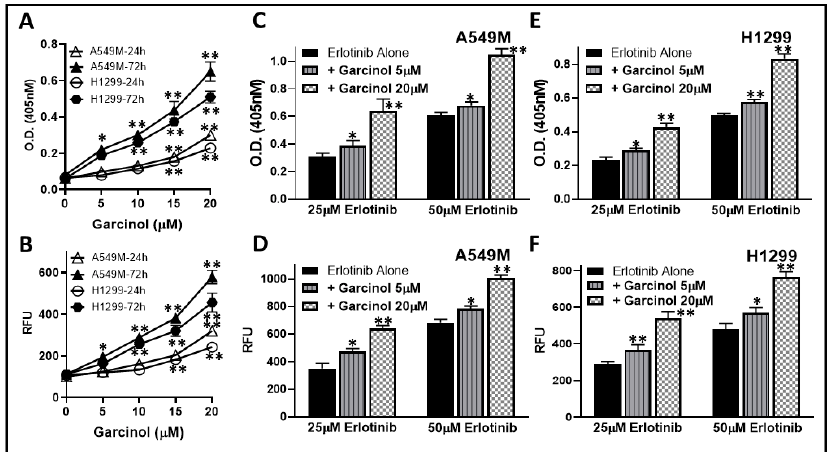
Figure 3. Garcinol potentiates apoptosis induction. A549M and H1299 cells were treated with increasing doses of garcinol for 24 h/72 h, and the induction of apoptosis was measured by Histone/DNA enzyme-linked immunosorbent assay (ELISA) ( A ) and homogeneous caspase-3/7 assay ( B ). * p < 0.05 and ** p < 0.01, compared to 0 µ M garcinol. A549M ( C , D ) and H1299 ( E , F ) cells were treated with 25 and 50 µ M erlotinib for 24 h in the absence (erlotinib alone) or presence of 5 and 20 µ M garcinol,